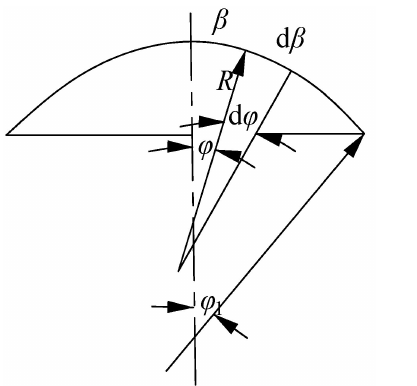
Figure 5. Analysis of the geometric relationship of a top cover cylindrical